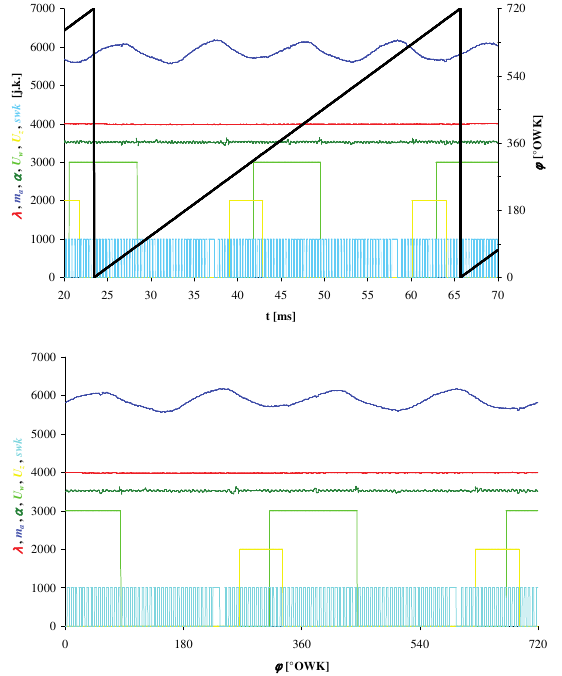
Fig. 10. Assignment of registered in time samples of signals to temporary angular position of engine shaft (chart above presents value of angle of f crankshaft in a cycle against the background of registered in time samples of signals, chart below present the same samples of signals in the function of f angle)